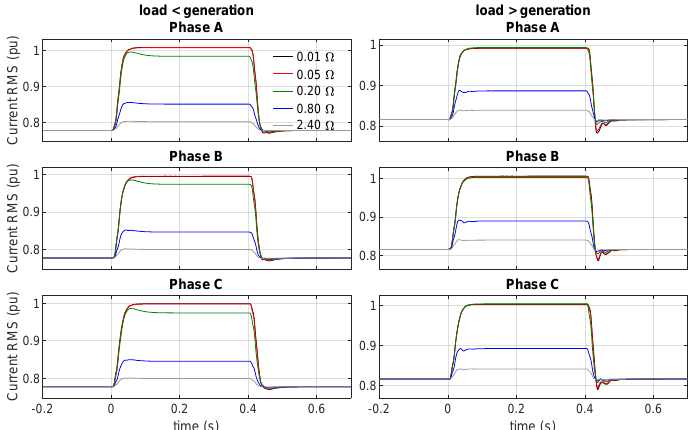
Figure 25. Phase currents at ST’s MV Inverter (AC side) following unbalanced phase-ground faults in the HV AC grid for the considered fault resistances.